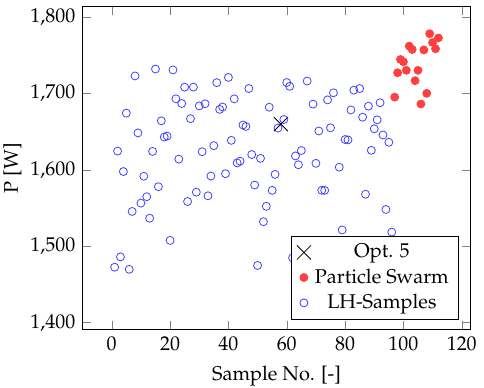
Figure 27. Scatter plot of the power achieved for all samples and the designs generated by the PSA.